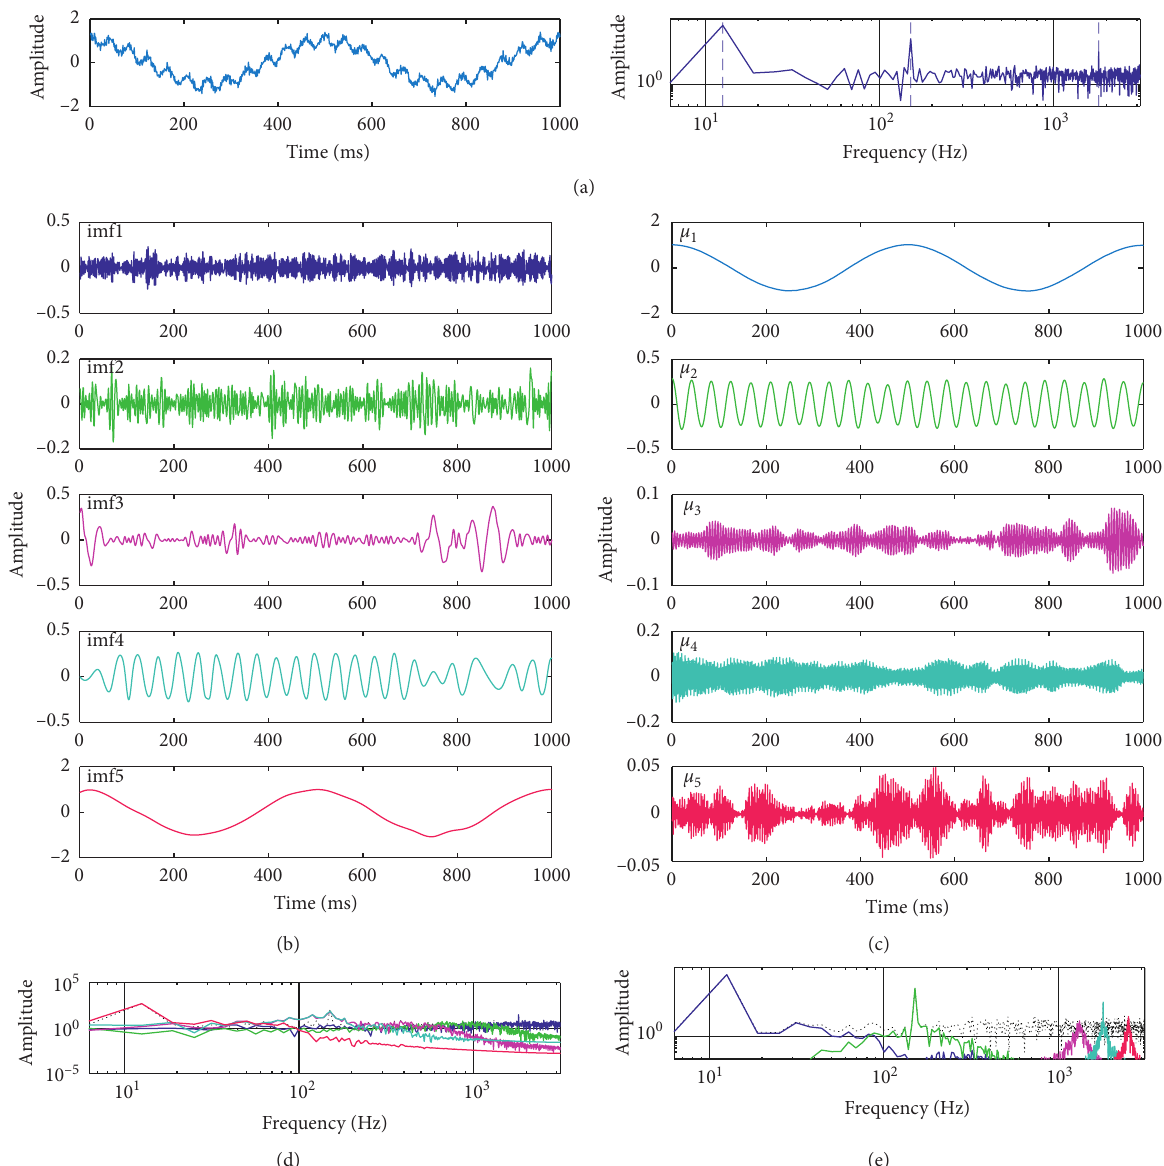
Figure 1: Decomposition of noisy triharmonic signal by EMD and VMD. (a) Noisy triharmonic signal and its spectrum. (b) EMD of noisy triharmonic signal with its IMF1-5. (c) VMD of noisy triharmonic signal with its u spectral by